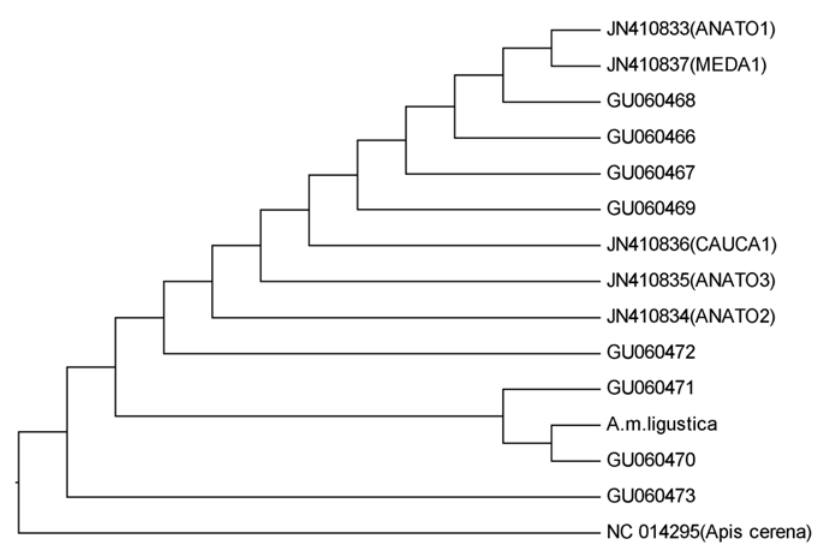
Fig. 2. Neighbour-Joining dendogram based on ND5 sequences of Apis mellifera haplotypes. Sequences obtained in this study are written in capital